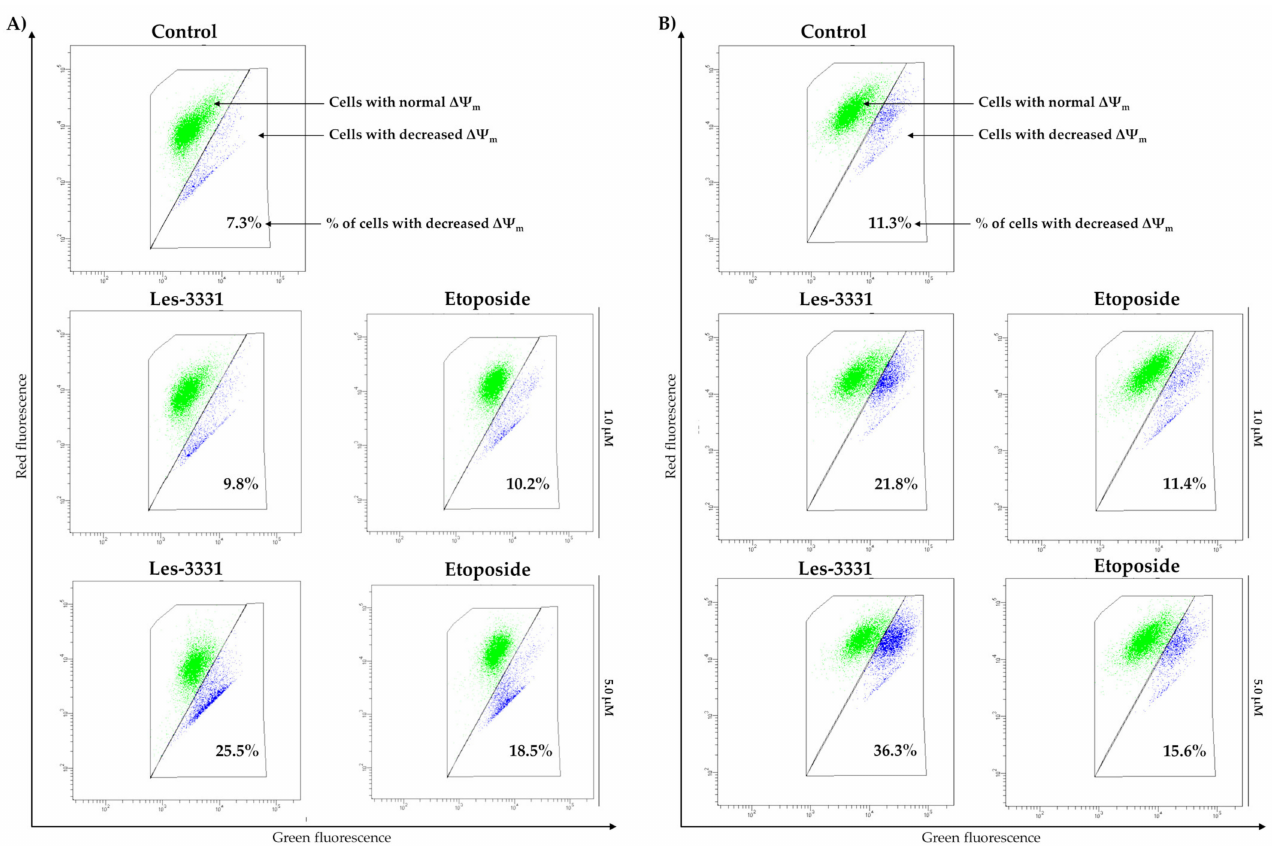
Figure 5. Mitochondrial membrane potential analysis in MCF-7 ( A ) and MDA-MB-231 ( B ) human breast cancer cells incubated with Les-3331 and reference drug (etoposide) at 1 µ M and 5 µ M concentration for 24 h. The total number of human breast cancer cells with decreased mitochondrial membrane potential is presented as the mean percentage from three independent experiments performed in